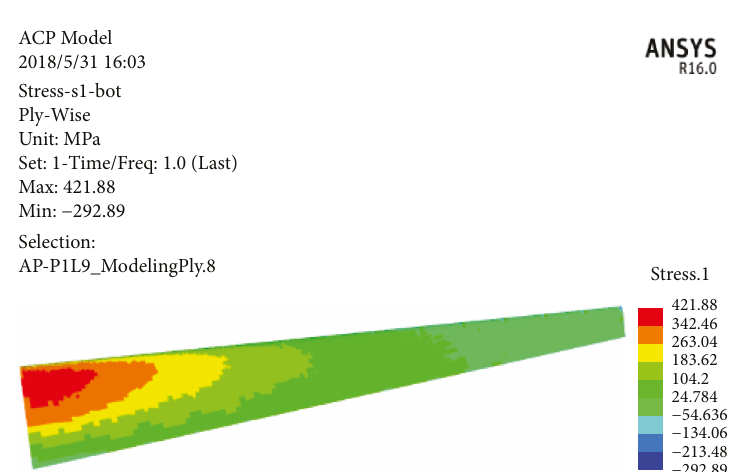
Figure 57: Stress cloud diagram of the upper wing with the layer ratio being 80%/10%/10%.